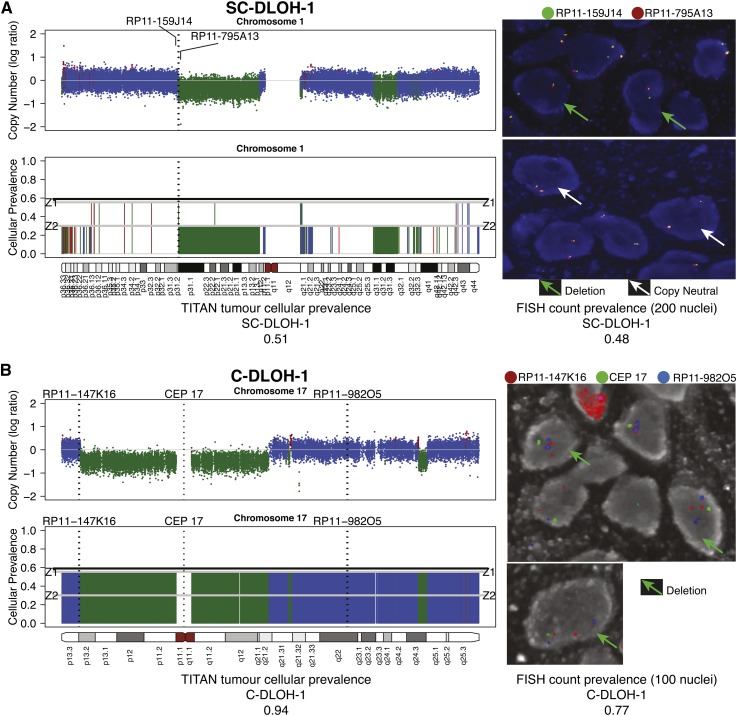
Fluorescence in situ hybridization (FISH) validation of TITAN predictions for Chromosomes 1 and 17 in DG1136g. (A) Subclonal hemizygous deletion, SC-DLOH-1, in Chromosome 1 was validated using BAC probe RP11-795A13 (orange, Chr1:69851036–70025173). Control probe for copy neutral regions was RP11-159J14 (green, Chr1:69454844–69606688). FISH imaging shows tumor cells with a deletion (green arrow) and diploid (white arrow) at this region. (B) Clonal deletion, C-DLOH-1, in Chromosome 17 was validated using the centromeric probe, CEP 17. The BAC probes RP11-147K16 (orange, Chr17:3294803–3452243) and RP11-982O5 (blue, Chr17:55475584–55662513) were used as controls. The majority of cells were observed to harbor the deletion. FISH count prevalence was computed as the proportion of nuclei with event:control count ratio that is <1 (deletion) or >1 (gain) (Supplemental Table 9H). FISH imaging is shown at 63× magnification. Copy number predictions are shown using log ratios (normalized tumor depth/normal depth). Copy neutral (blue), hemizygous deletion (green), and copy gain (red) predictions are shown. Cellular prevalence estimates for clonal cluster 1 (Z1) and cluster 2 (Z2) predicted by TITAN are shown; tumor cellularity is indicated by the black horizontal line.